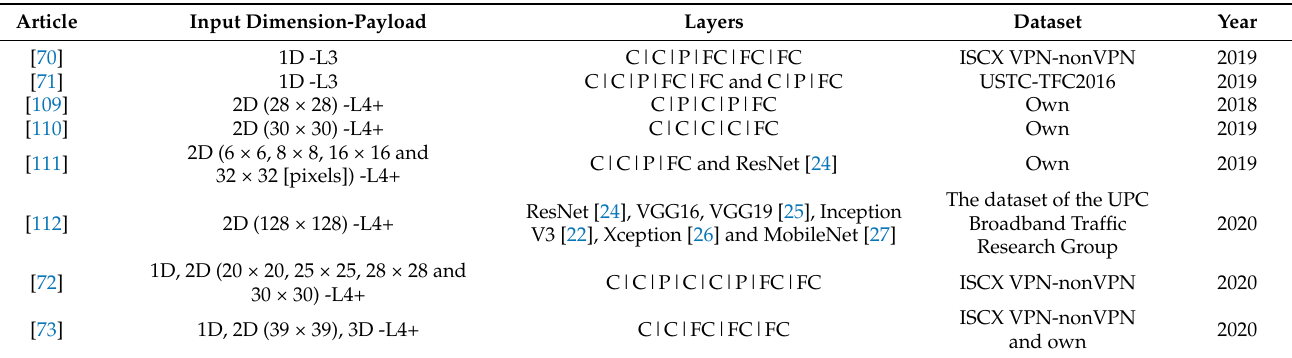
Table 5. Works that extract payload of raw